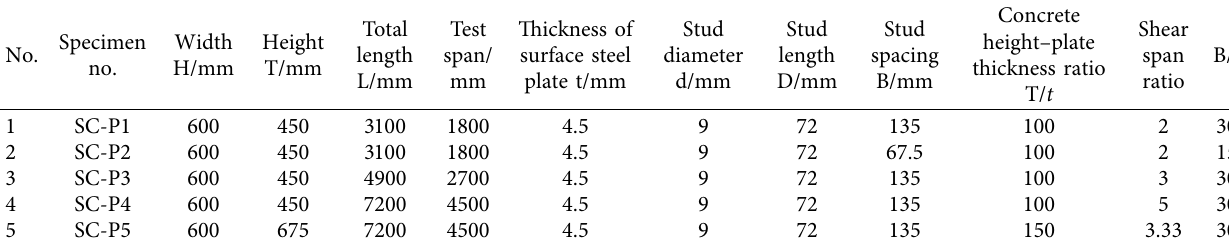
Figure 1: Diagrams of steel-concrete composite shear wall and specimens. Table 1: List of specimen dimensions.